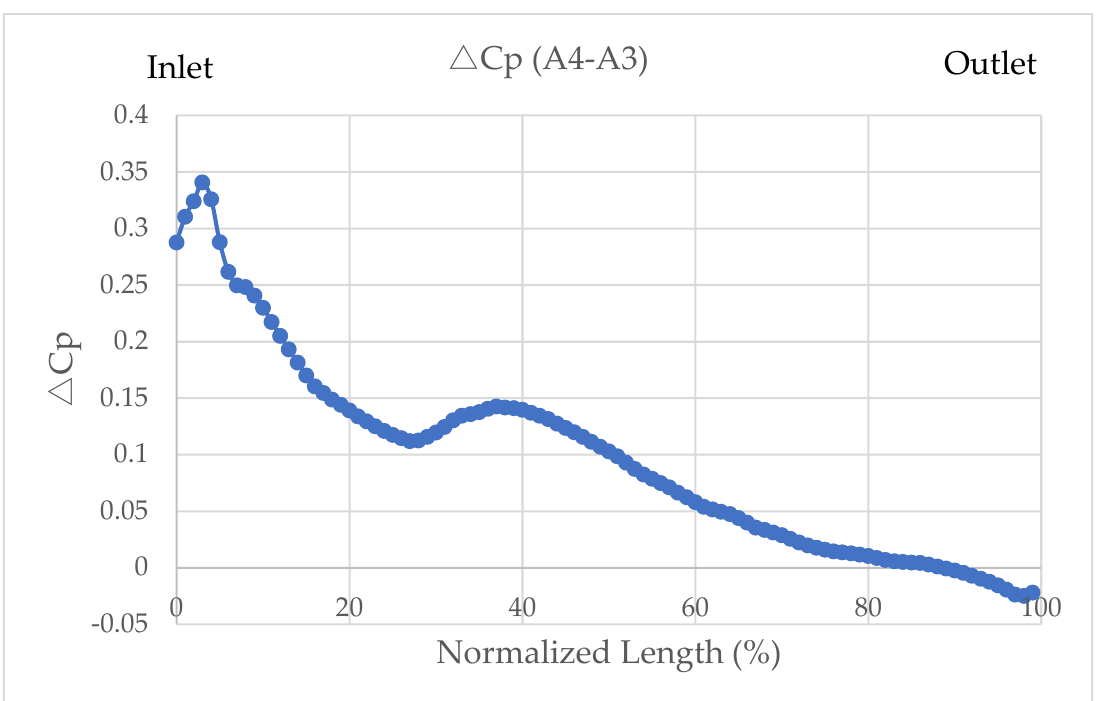
Figure 25. Velocity vectors in the gap in which an accommodation house is located.